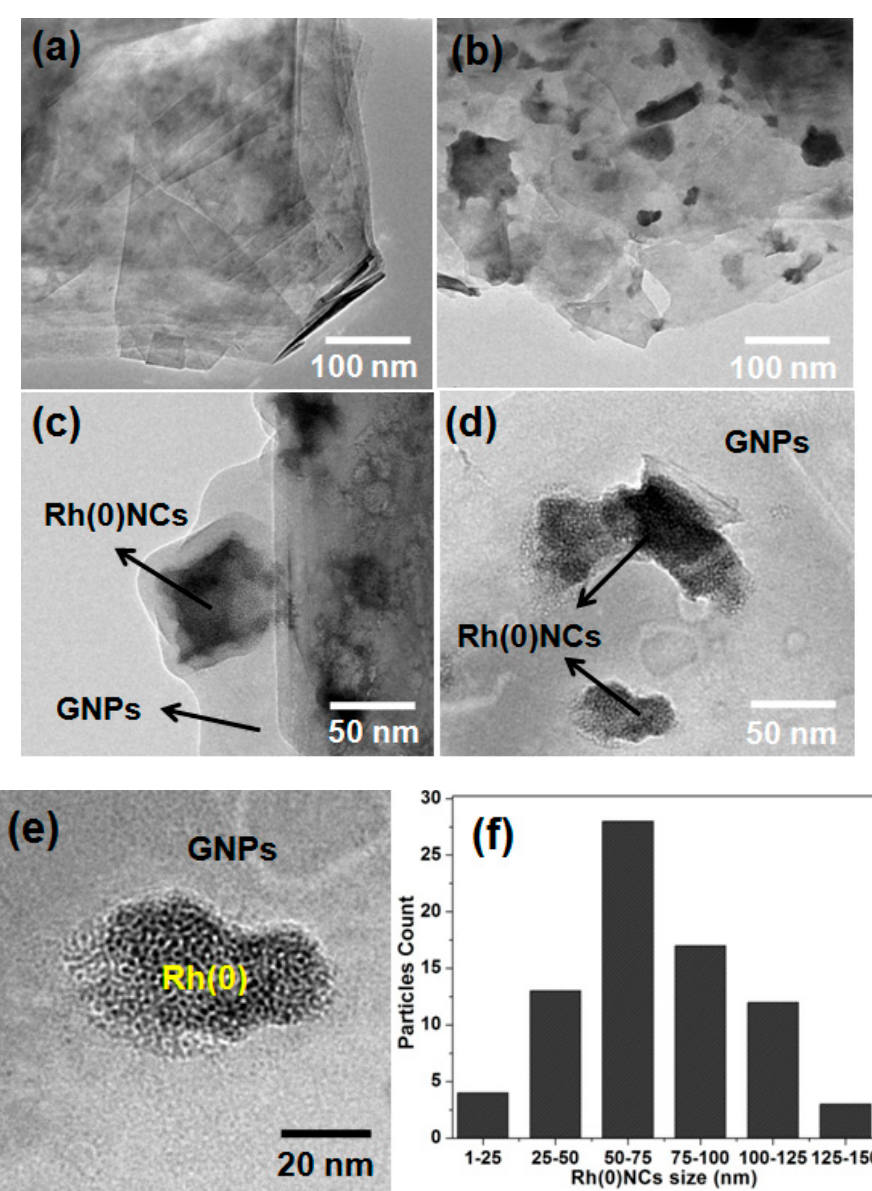
Figure 1. Transmission electron microscope (TEM) images of ( a ) fresh GNPs, ( b – e ) Rh(0)NCs/GNPs, and ( f ) the size distribution of Rh-clusters in Rh(0)NCs/GNPs.